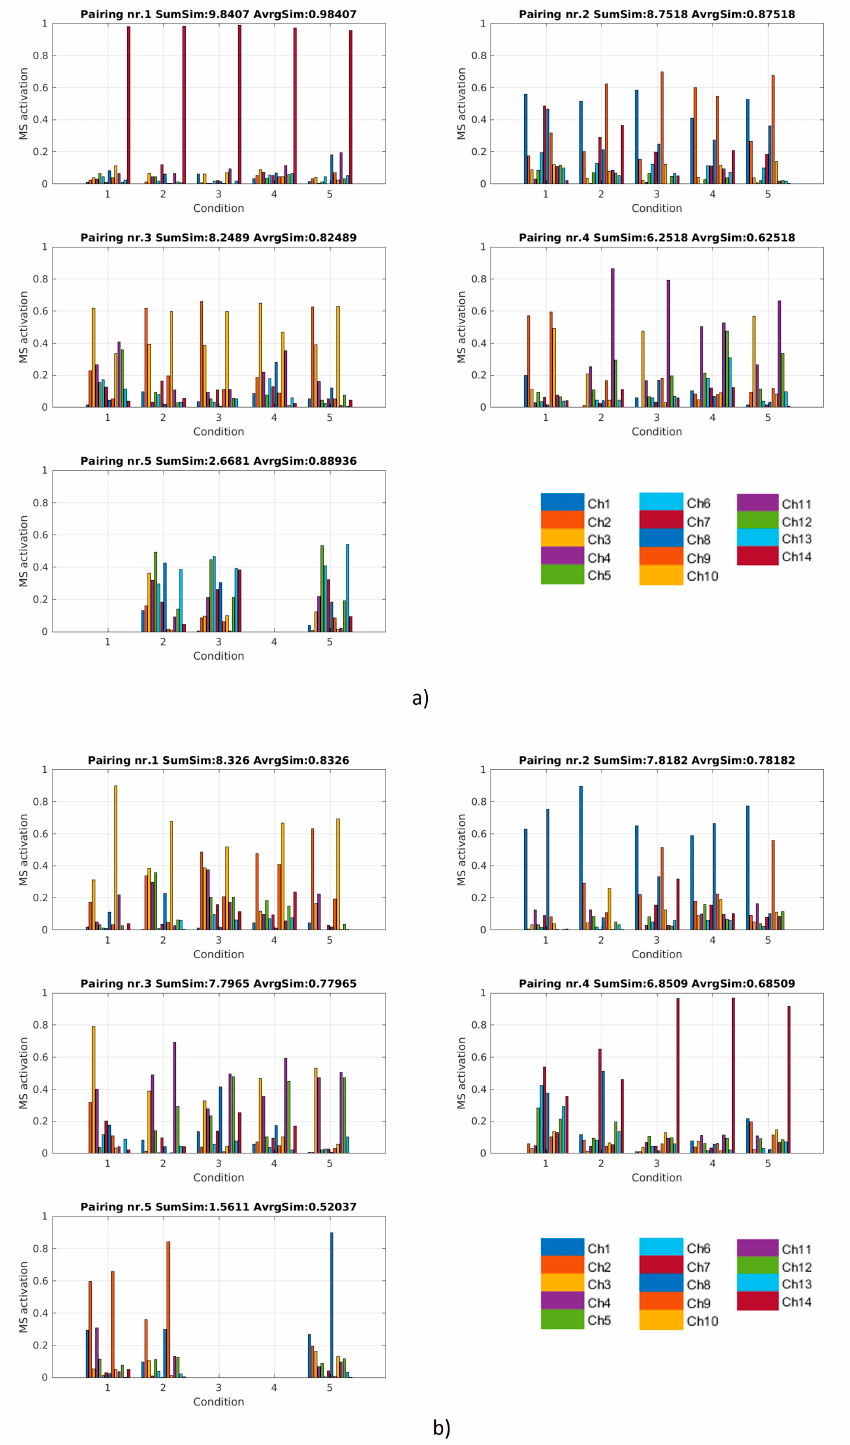
Figure 13. A typical person with a high inter-session matching score ( a ) and lower inter-session matching score ( b ): In both cases, a VAF of 85% was considered. The X axis represents five sessions from which synergies were extracted. On the top-left graph, five synergies (one for each session) are shown and they represent a group of the five synergies with the highest similarity, chosen from the pool of synergies extracted for all five sessions. The groups of synergies in each subplot show the result of optimal matching of synergies. In the titles, the average similarity and the sum of all pairwise similarities in a given matching group (cluster) is reported. Clusters were sorted based on the sum of similarities